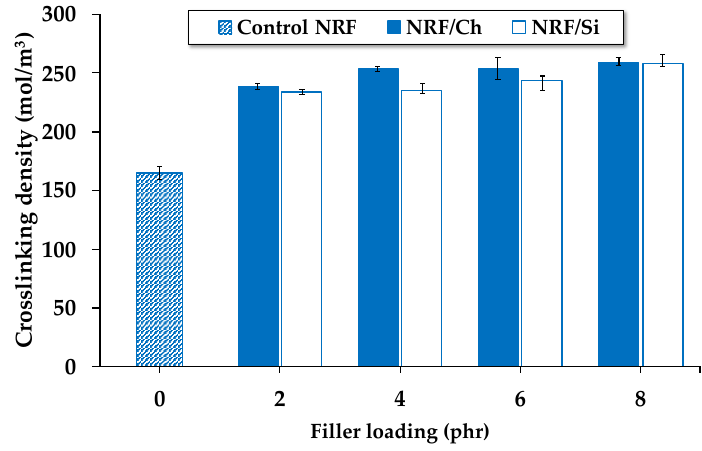
Figure 2. Effect of filler loading on the crosslinking density of the NRF samples.